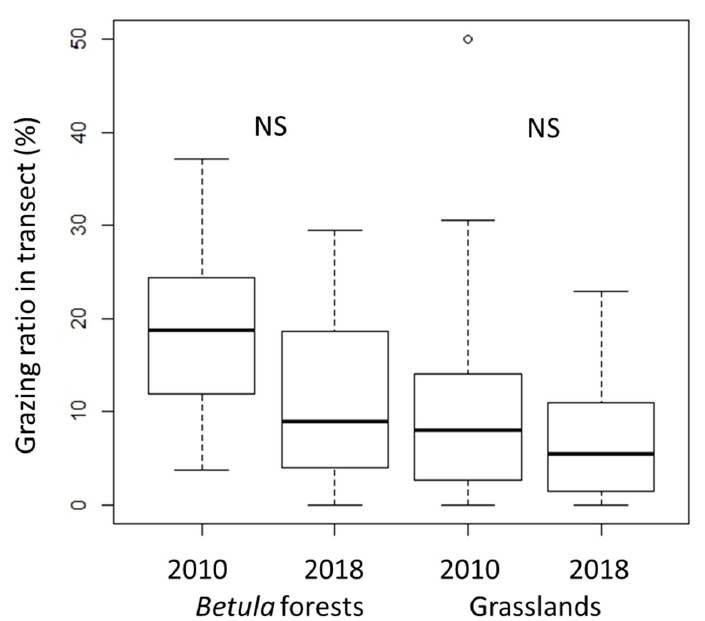
Figure 4. Changes in grazing ratios (%). Grazing ratios were calculated as the ratio of the total grazed occurrence frequency to the total occurrence frequency in each transect. Vertical bars show standard deviations. The exact Wilcoxon signed-rank test was used to compare the 2010 data with later census data. NS, not significant.